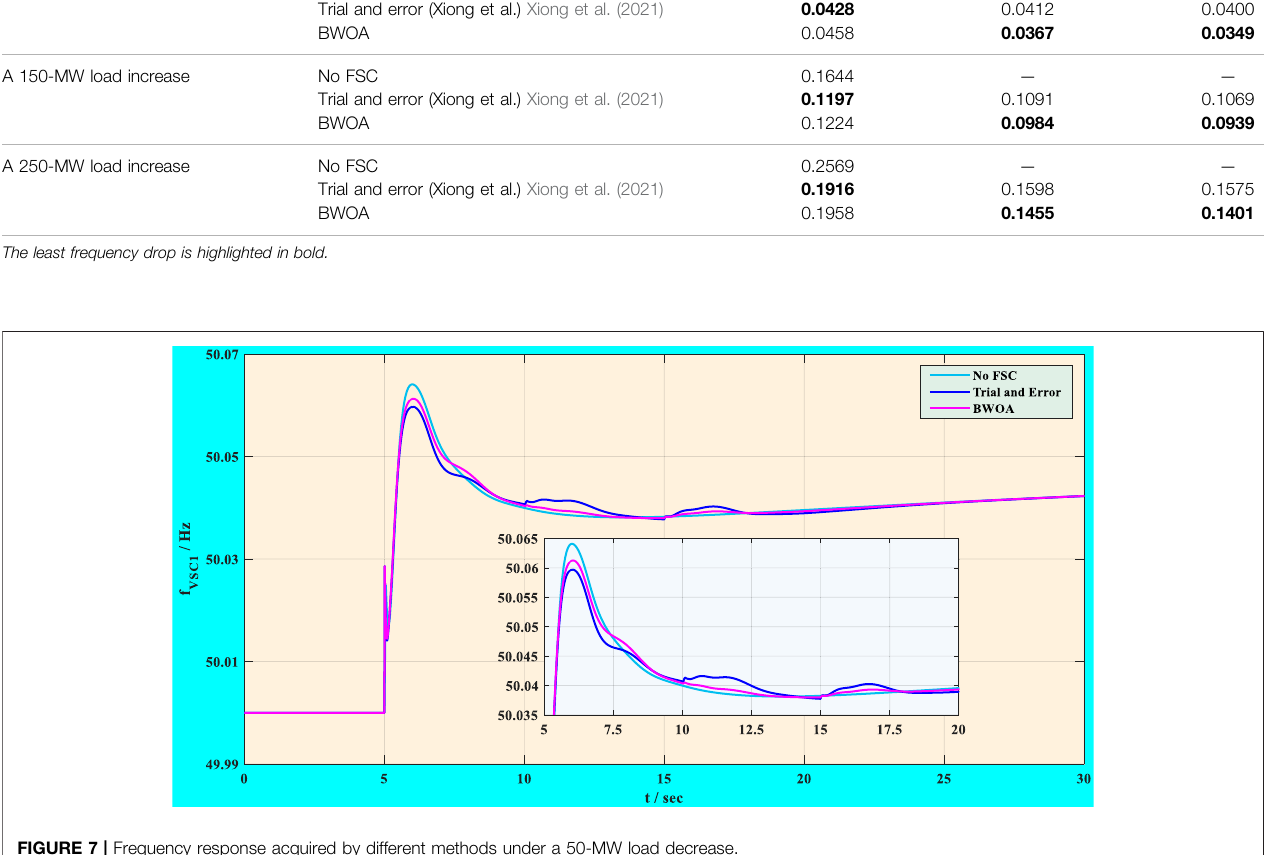
FIGURE 7 | Frequency response acquired by different methods under a 50-MW load decrease.